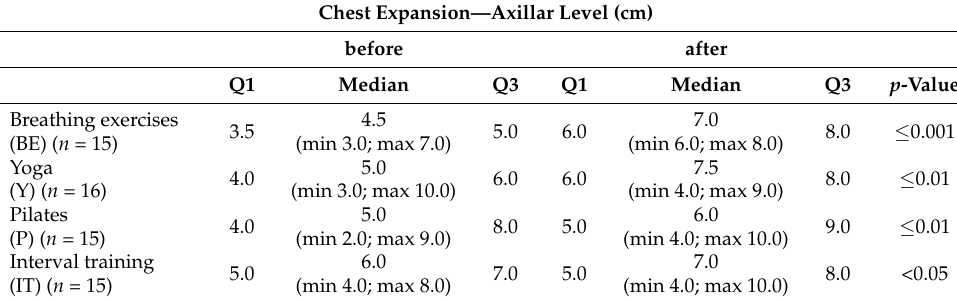
Table 2. Results of the chest expansion (cm) of the four groups (target BE programme and three other programmes: yoga, Pilates and dynamic interval training) before and after the training period. The students participated voluntarily in and were randomly assigned to training programmes. The duration of each training session was one hour, twice a week for 7 weeks. Chest Expansion—Axillar Level (cm)